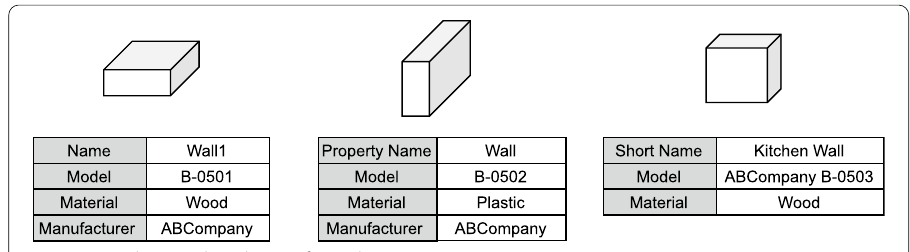
Fig. 4 Example textual attributes of BIM